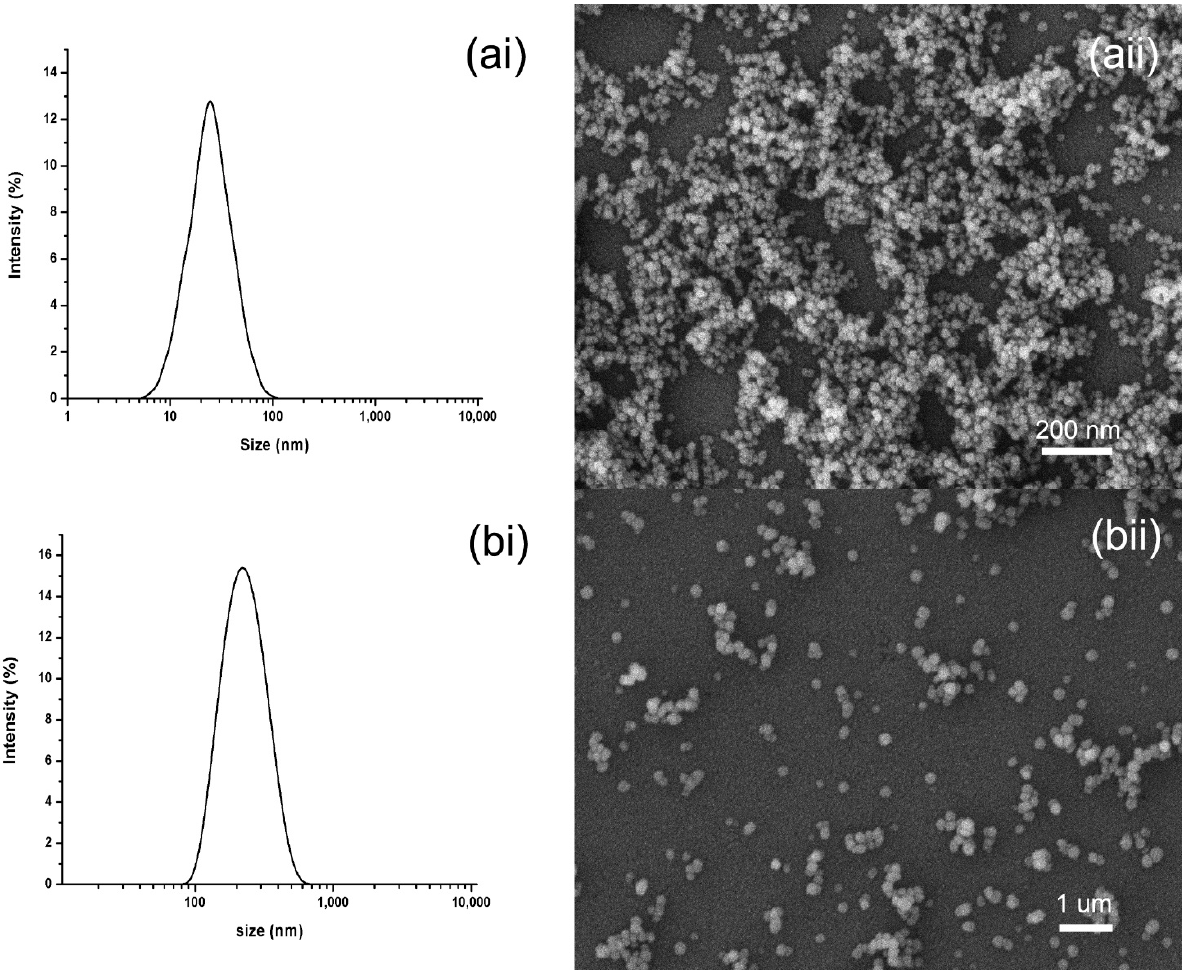
Figure 6. The DLS and SEM characterization of BNPs using AAO templates with pore size of 20 nm and 200 nm. ( ai ) DLS image of BNPs using AAO templates with pore size of 20 nm, ( aii ) SEM image of BNPs using AAO templates with pore size of 20 nm, ( bi ) DLS image of BNPs using AAO templates with pore size of 200 nm, ( bii ) SEM image of BNPs using AAO templates with pore size of 200 nm